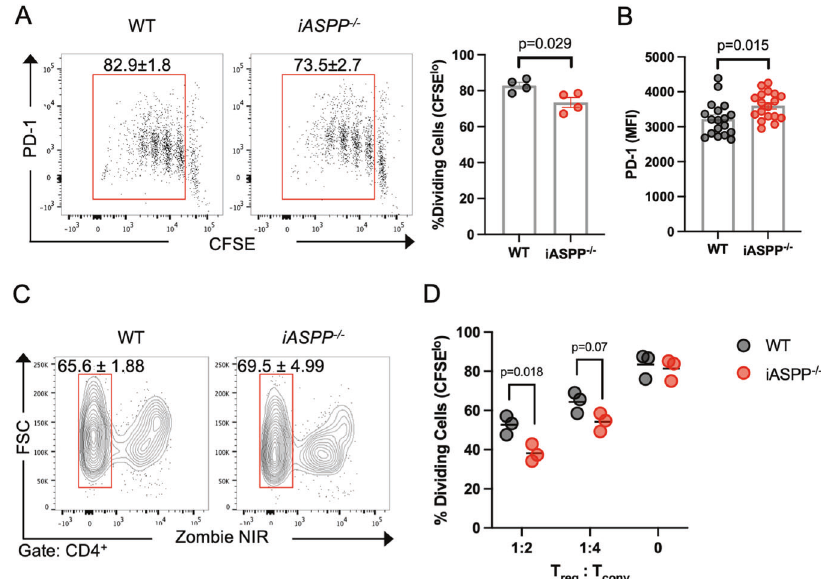
Fig. 1 iASPP De fi ciency Attenuates CD4 + T Cell Activation and Potentiates Treg Function. A Flow cytometry dot plots (left) and quanti fi cation (right) of CD4 + T cell division 72 h after anti-CD3 stimulation analyzed by CFSE dilution. B Flow cytometric quanti fi cation of PD- 1 expression in CD4 + T cells in ( A ). MFI median fl uorescent intensity. C Flow cytometry contour plots of live-dead stain of CD4 + T cells 72 h after anti-CD3 stimulation. D Flow cytometric quanti fi cation of suppressive activity of T reg cells examined by cellular division of responder T conv cells as measured by CFSE dilution 72 h after